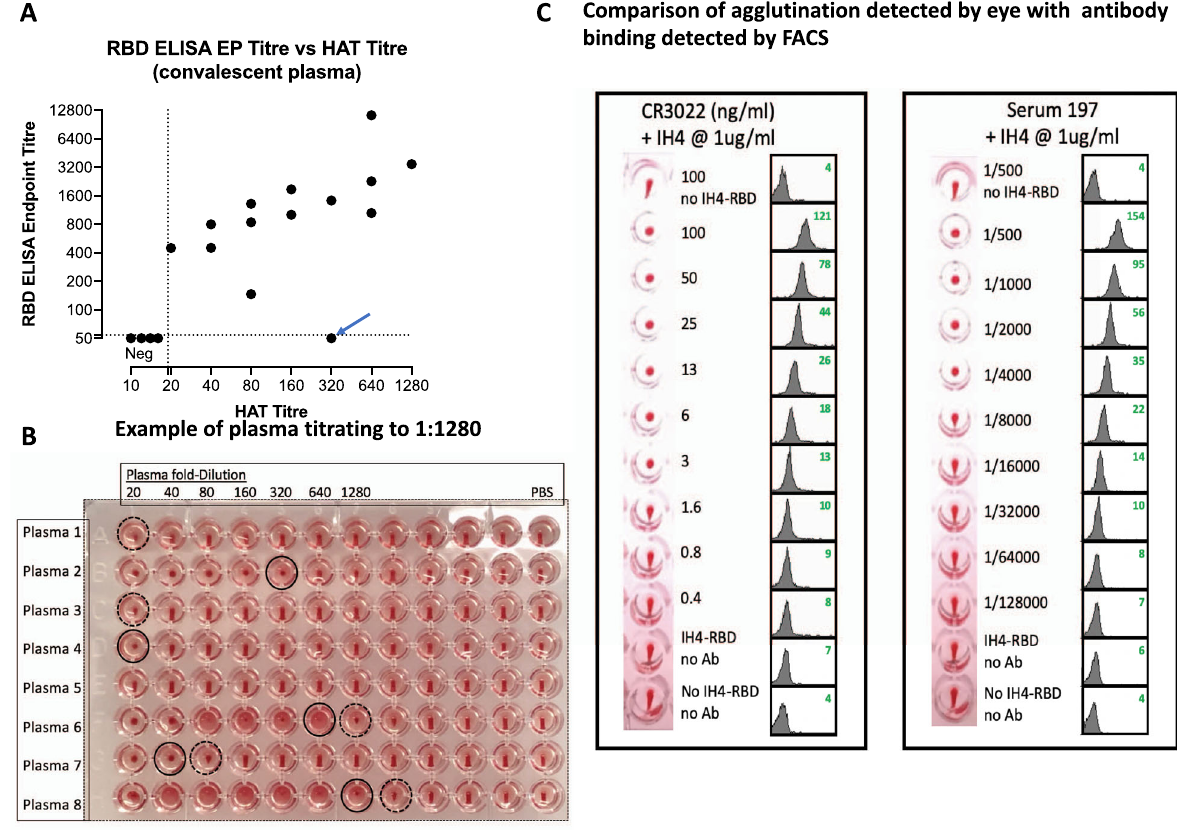
Fig. 3 Titration of antibodies in the agglutination assay. A Eighteen plasma samples from mild cases were compared for titration in the HAT with 1:40 O − ve whole blood from a seronegative donor and endpoint titre in an RBD ELISA 32 . Four samples were negative in both assays. The data point marked with an arrow on the graph (plasma 2 on the plate, Fig. 3B) was checked with a reagent composed of IH4 without RBD and shown to be dependent on antibodies to the RBD. This sample did score positive for antibodies to full length spike in an ELISA (endpoint titre 1:1123). These results were con fi rmed in a repeat assay. B An example of titration: positive agglutination endpoints (loss of teardrop) are marked with a black solid-line circle, partial teardrops are marked with a dotted-line circle. C Titration of mAb CR3022 and a high titre serum from a COVID-19 patient show that agglutination in the HAT detected by eye correlates with antibody binding to RBCs, as revealed by FACS analysis. Standard HAT titration was performed by double dilutions of RBC suspension containing 1 µ g/mL of the IH4-RBD reagent, bar the fi rst and last well. After the HAT assay, the RBCs were stained for FACS analysis by performing three washes before incubation for 60 min at 4 °C with FITC-labelled goat – anti-human IgG. RBCs were then washed twice before analysis by fl ow cytometry. Green numbers in the upper right corners of the histograms correspond to the geometric mean fl uorescence intensity. Original graphs are provided as Supplementary Fig. 4. Similar results were obtained in three other